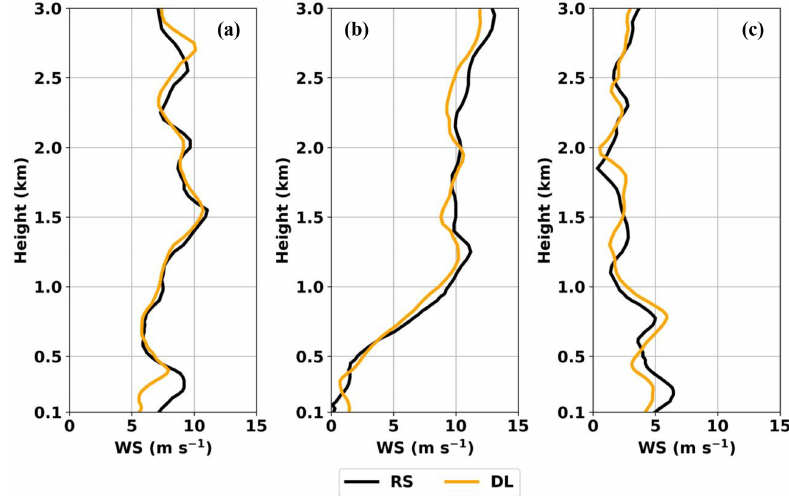
Figure 4. Vertical profiles of horizontal wind speed (WS) measured by DL and RS at three NYSM Profiler Network sites at (a) Buffalo and (b) Albany at 19:00LT (23:00UTC) on 19 July and (c) Stony Brook at 19:00LT (23:00UTC) on 20 July